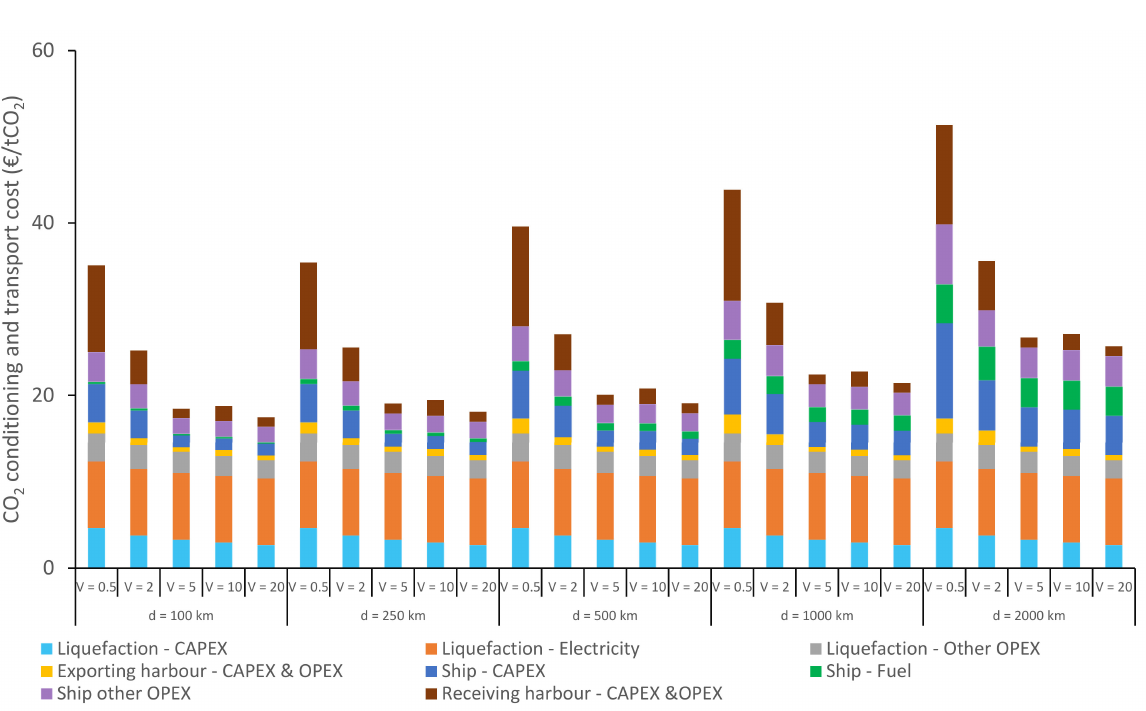
Figure A12. Cost breakdown of CO 2 conditioning and transport costs as a function of transport distance (d in km) and annual volume (V in MtCO 2 /year) when transporting pure CO 2 to an offshore site by ship at 7 barg.